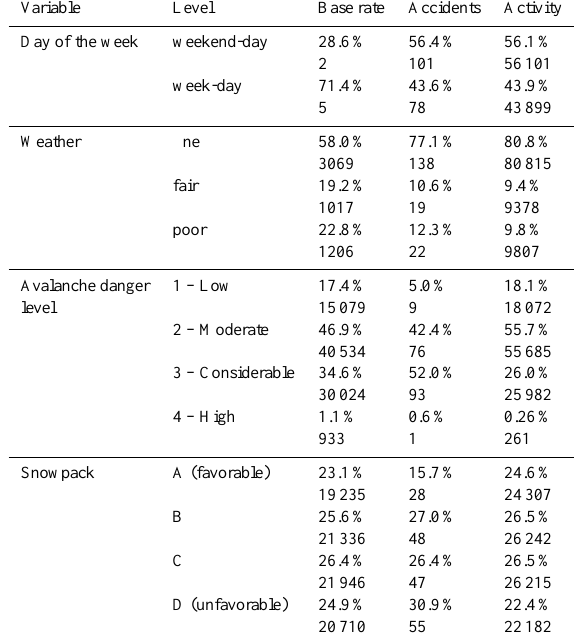
Table 1. Overview of the data for the base rate of the weather, avalanche danger and snowpack conditions (e.g. the frequency a danger level was forecast), and the distribution of activity and acci- dents. Relative and absolute frequencies are